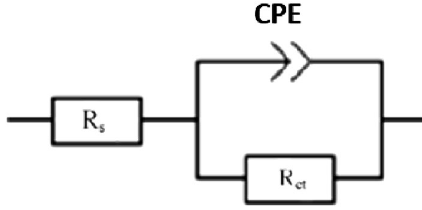
Figure 5. Equivalent circuit model.